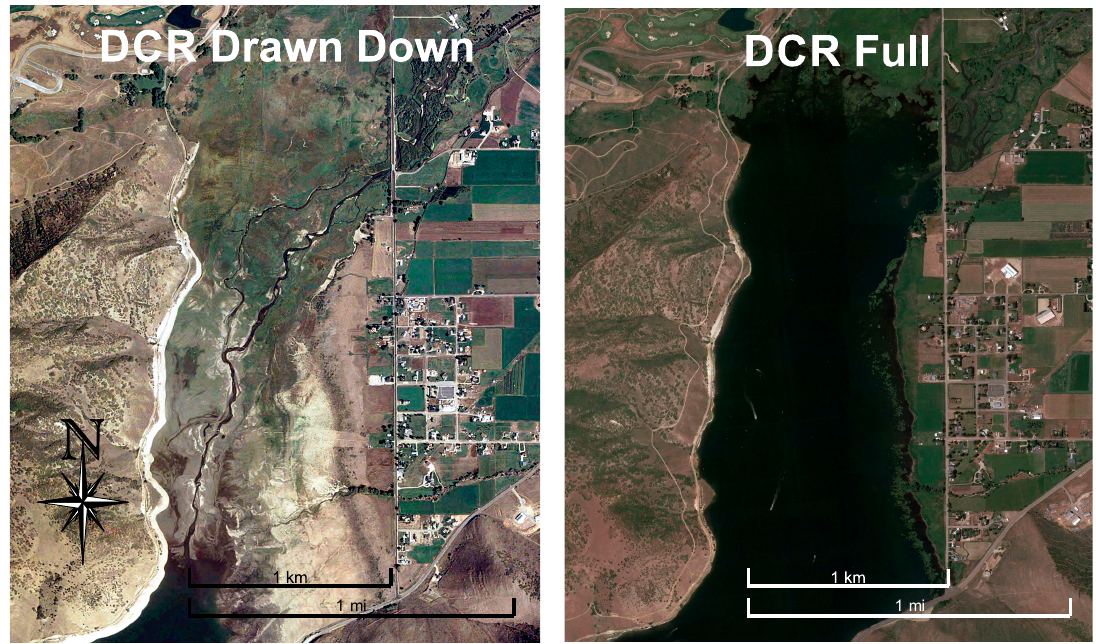
Figure 1. Exposed sediment delta showing the gradual slope and the incision by the influent streams. The left is approximately 3 km (2 miles) of delta that was exposed during a dam reconstruction project, the right image shows the lake with a typical pool elevation. The typical annual drawdown only exposes about half this amount, or about 1.5 km (1 miles) of the delta.